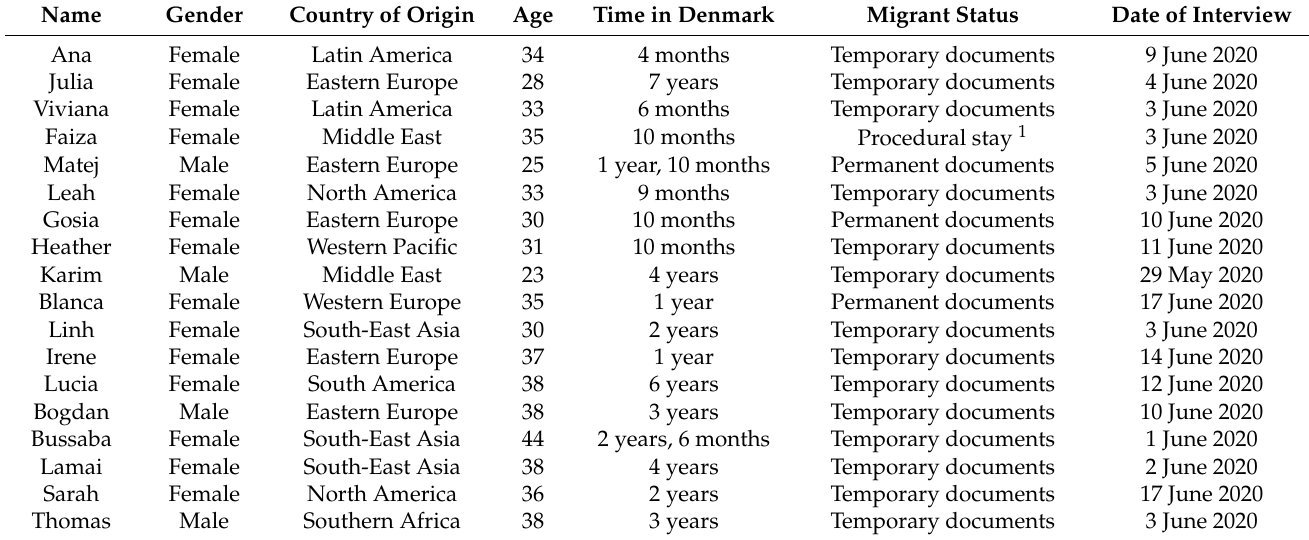
Table 1. Participant